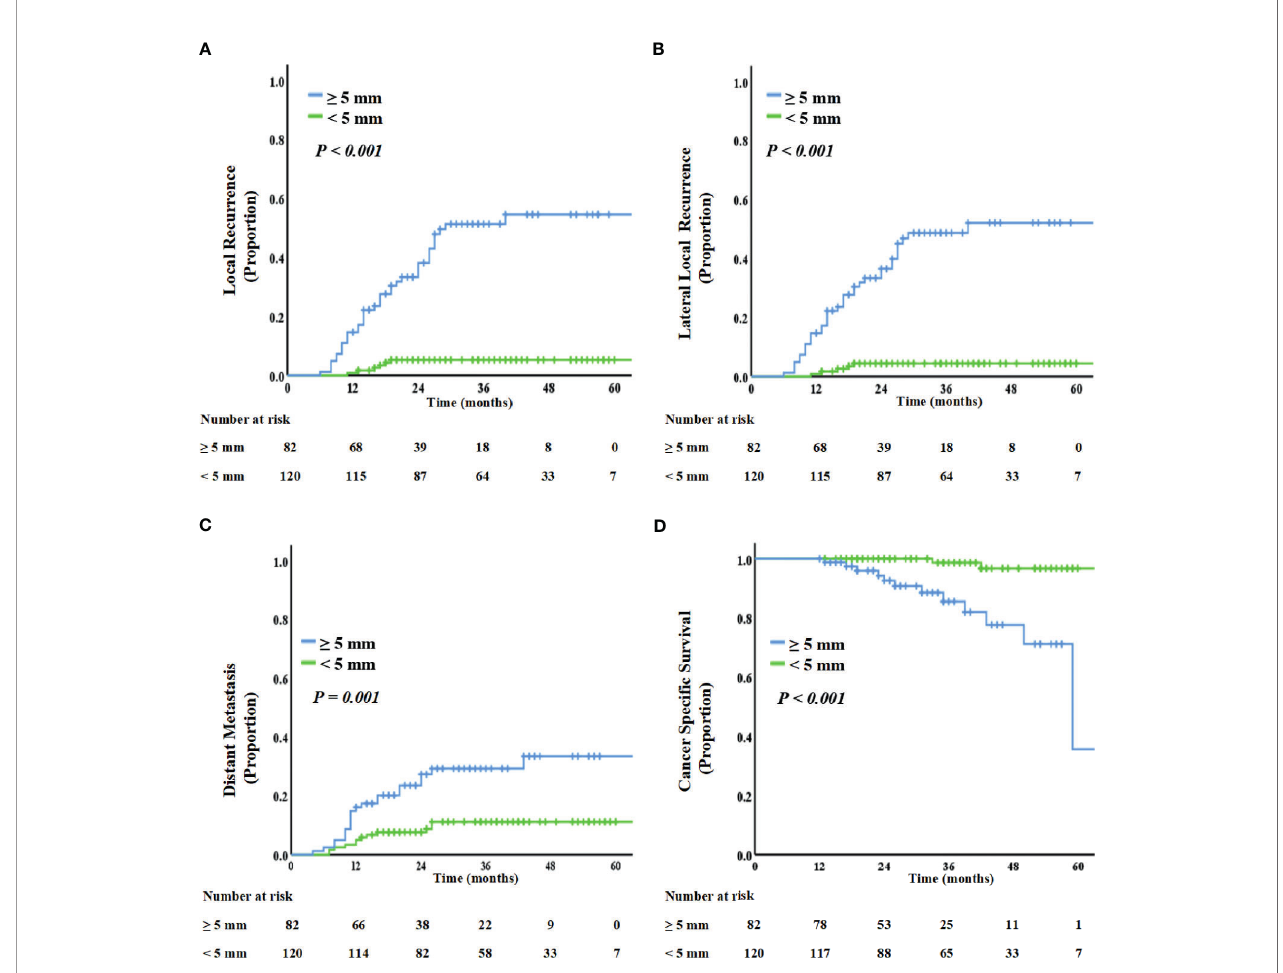
FIGURE 3 | Kaplan – Meier curve analysis of local recurrence (A) , lateral local recurrence (B) , distant recurrence (C) , and cancer-speci fi c survival (D) , comparing patients with LLN SA ≥ 5 mm or <5 mm on restaging